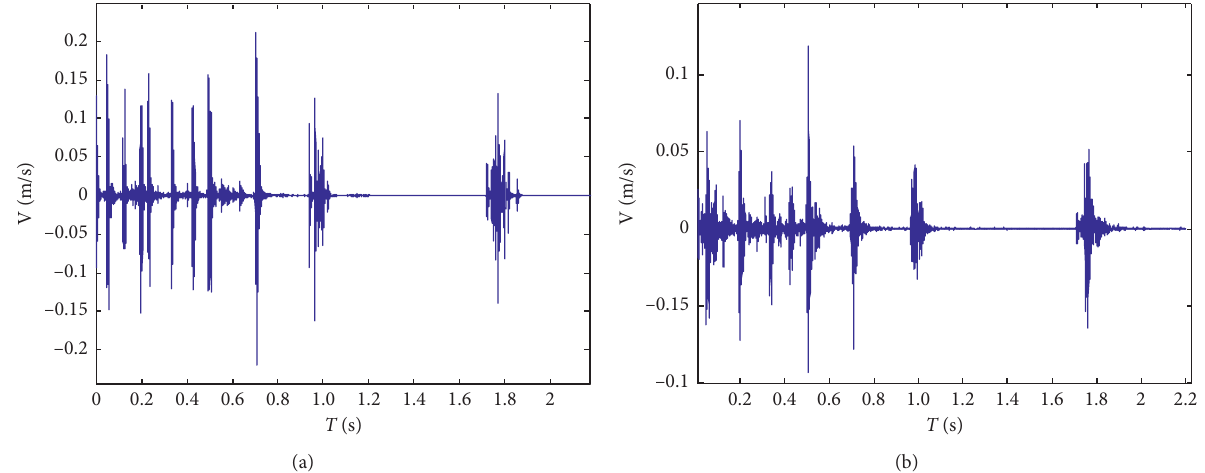
Figure 3: Typical blasting vibration waveform of the (a) usual charge and (b) cutting seam